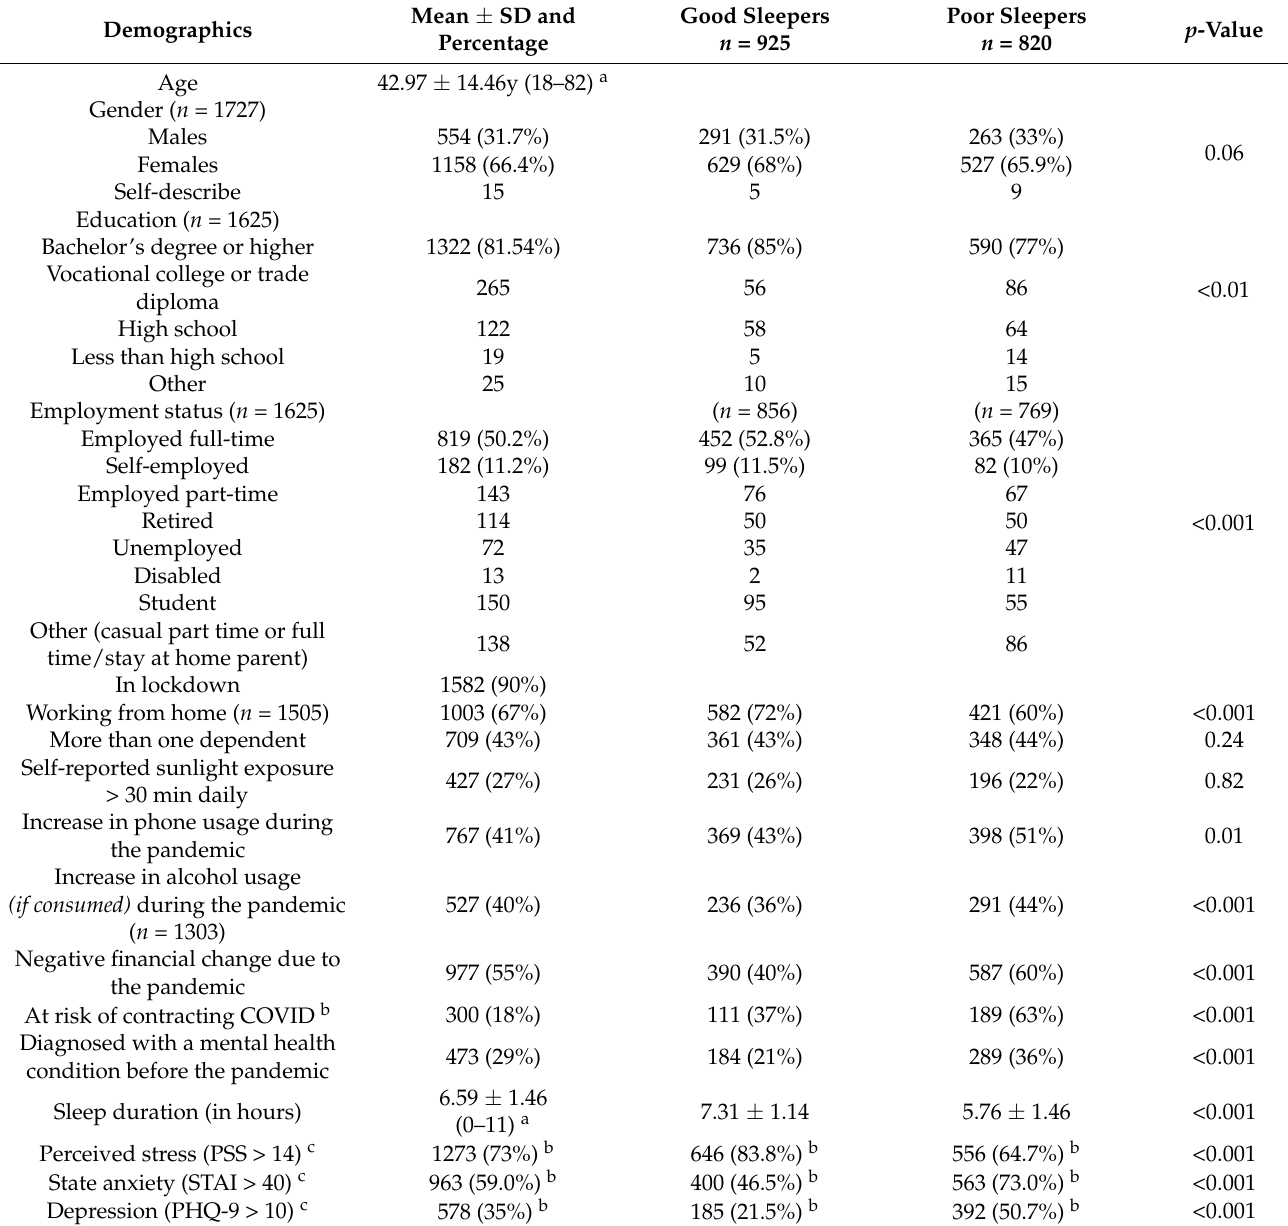
Table 1. Participant characteristics ( N =